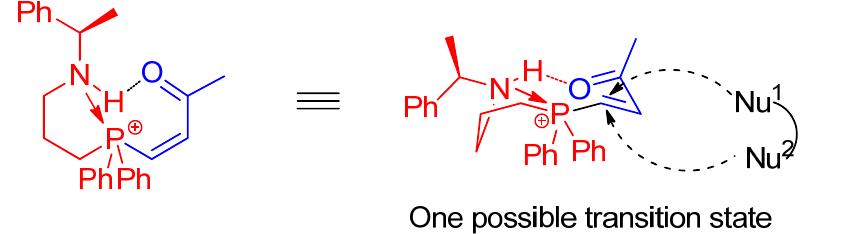
Figure 3. Transition intermediate featuring intramolecular hydrogen